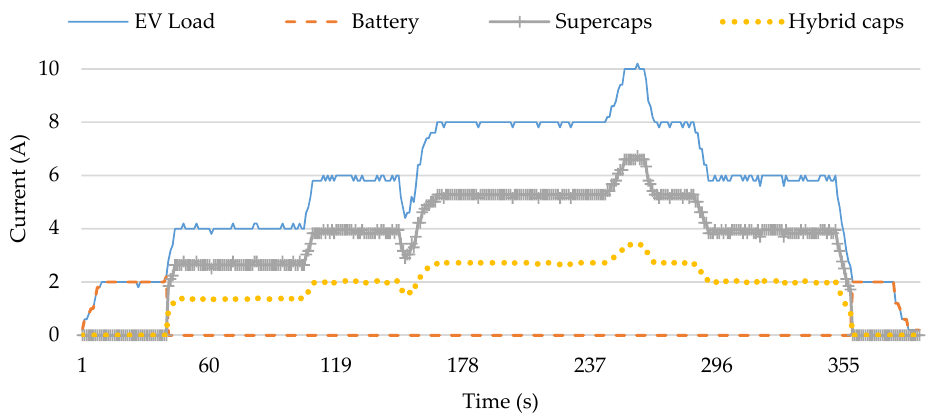
Figure 14. Experimental result of the hybridisation topology with SC and HC connected directly in parallel and hybridised through one port; a test using a realistic EV profile.